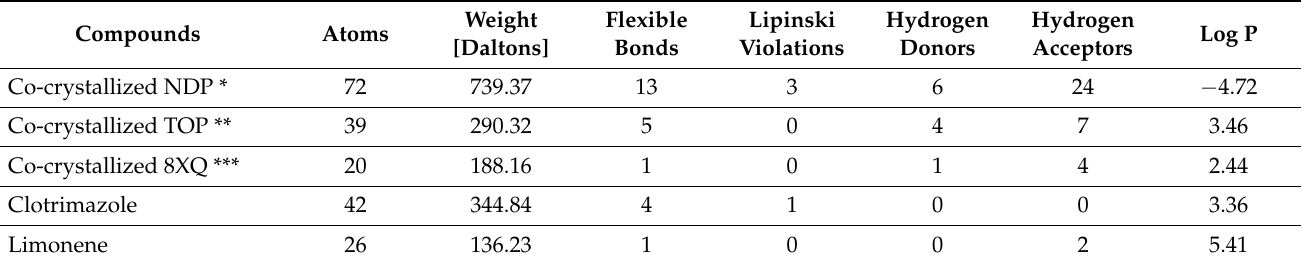
Table 9. Predicted properties of ligands generated by CLC Drug Discovery